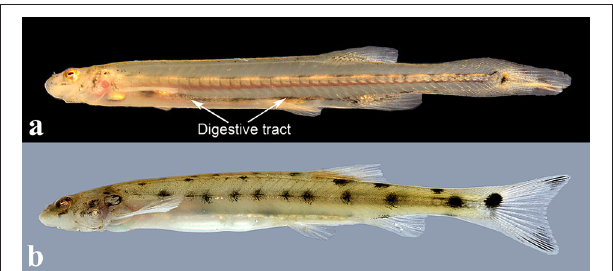
FIGURE 1 | Studied species of Stegophilinae. (a) Homodiaetus anisitsi , 32mm standard length, specimen from Lagoa dos Quadros, rio Tramandaí basin, Rio Grande do Sul State, Brazil. (b) Pseudostegophilus maculatus , 38mm standard length, specimen from rio Ibicuí, rio Uruguay basin, Rio Grande do Sul State, Brazil. Arrows indicate the digestive tract, visible by transparency as a relatively straight tube from the mouth to the anus.